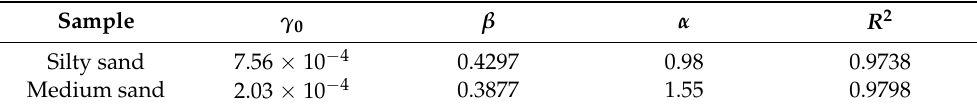
Table 5. Fitting parameters of the empirical relationship between G / G max and shear strain γ for silty and medium sand in the East Nao-ao area.